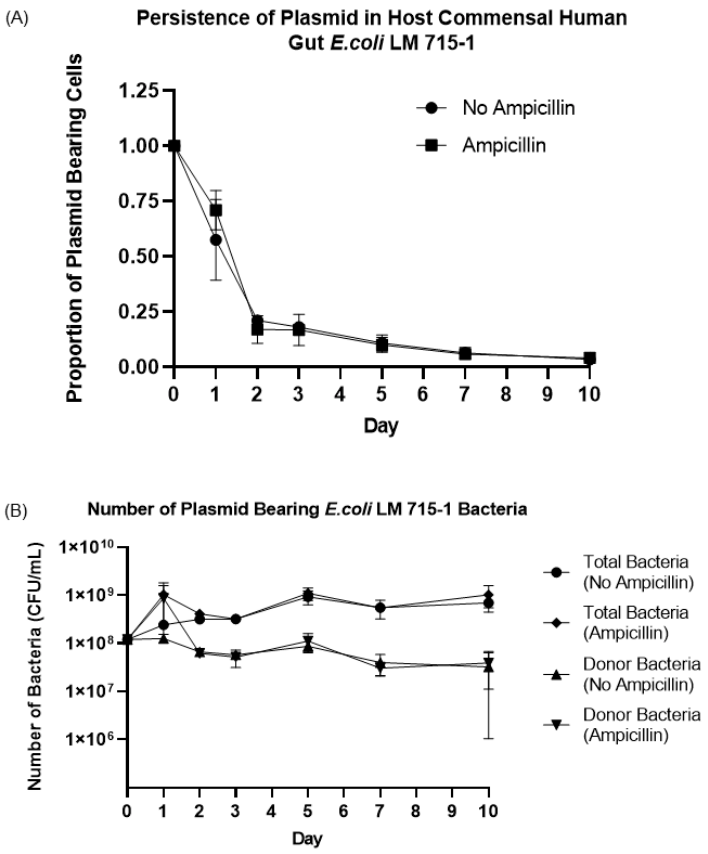
Figure 7. Proportion and number of donor bacteria carrying the RP4 plasmid during serial passage in medium with or without ampicillin. ( A ) Proportions of bacterial cells carrying RP4 plasmid (donor bacteria) and total bacteria (with and without plasmid) were calculated in both groups (ampicillin-treated and untreated) on days 0, 1, 2, 3, 5, 7, and 10. Bars indicate mean values ± standard error of the mean (SEM) based on three independent replicates (n = 3) of each experimental group. ( B ) The actual number of bacteria carrying plasmid and total bacteria with and without plasmid is shown for each treatment group. Bars indicate mean values ± standard error of the mean (SEM) based on three independent replicates (n = 3) of each group of the experiment.